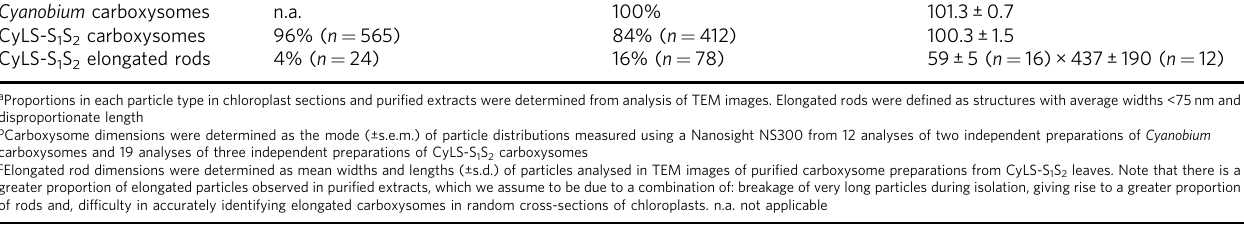
Table 1 Elongated carboxysome numbers in chloroplast cross-sections and in puri fi ed preparations Particle type